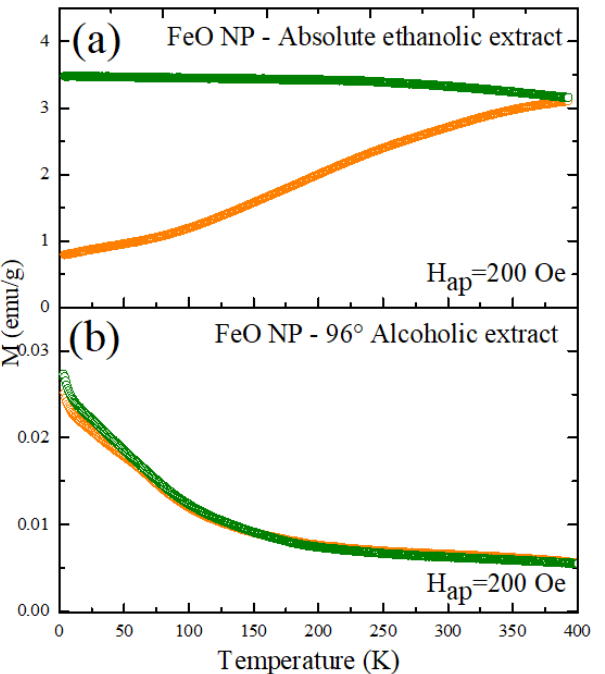
Figure 10. Magnetization curve as a function of temperature at low fields, under the ZFC and WFC protocols ( a ) FeO NP Absolute ethanolic extract, ( b ) FeO NP 96° alcoholic extract.